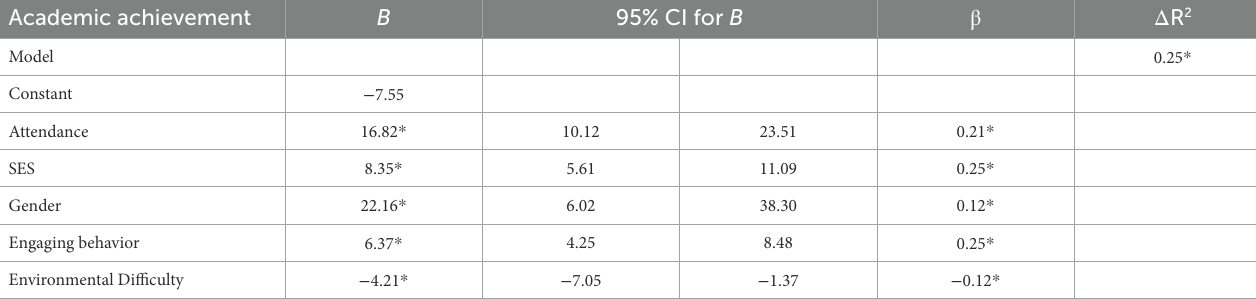
TABLE 6 Regression statistics for model with five predictor variables and academic achievement as outcome variable.